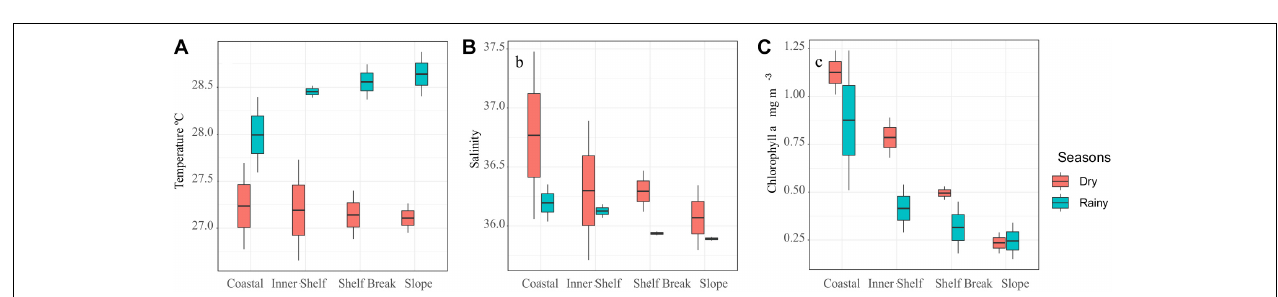
FIGURE 3 | Box-plot of the temperature (A) , salinity (B) , and chlorophyll- a (C) at the coastal and oceanic areas off Rio Grande do Norte, Southwestern Atlantic (Source: Petrobras, Bacia Potiguar-RN